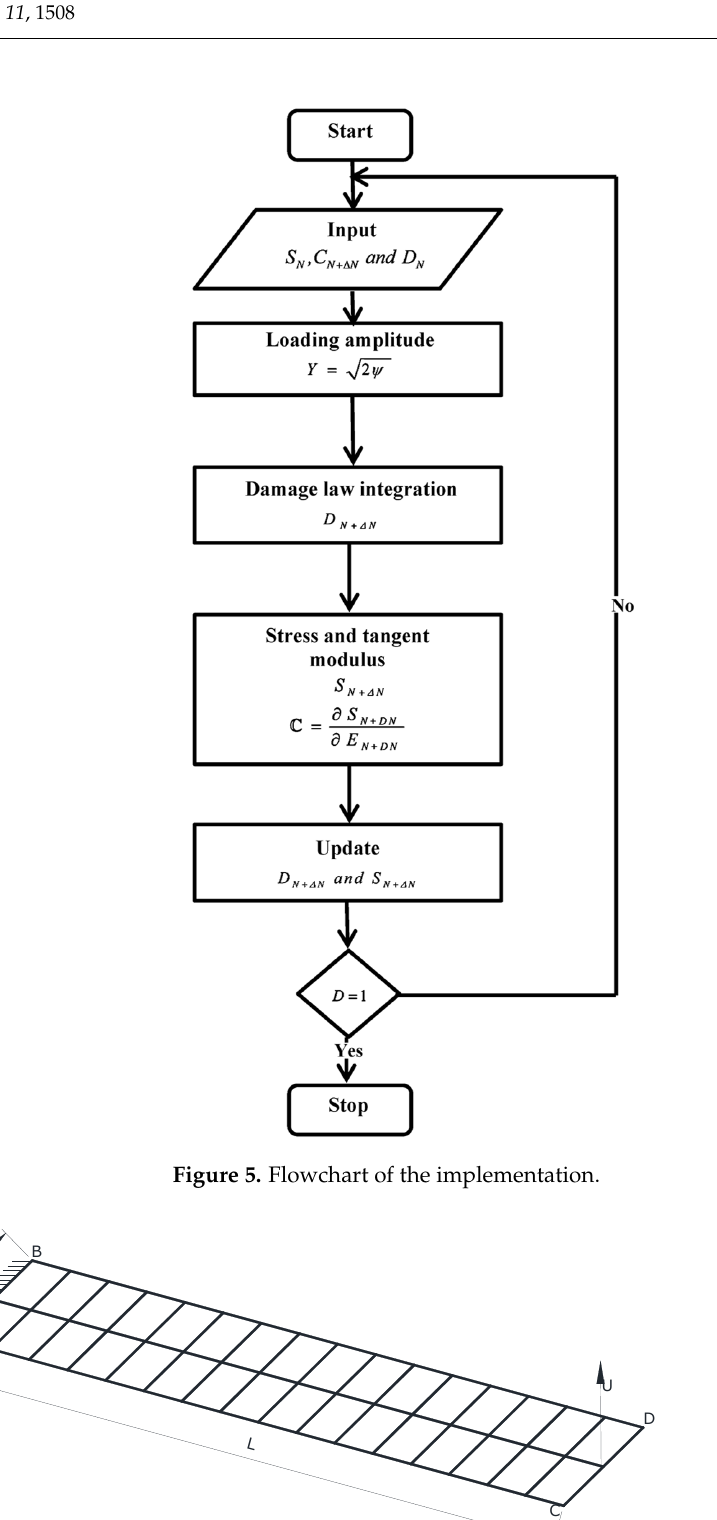
cycles), the total damage is estimated via the fourth-order Runge–Ku tt a integration method (Equation (54)) [61]. This damage estimate can be used to predict new material properties, and the simulation is repeated iteratively until total failure (